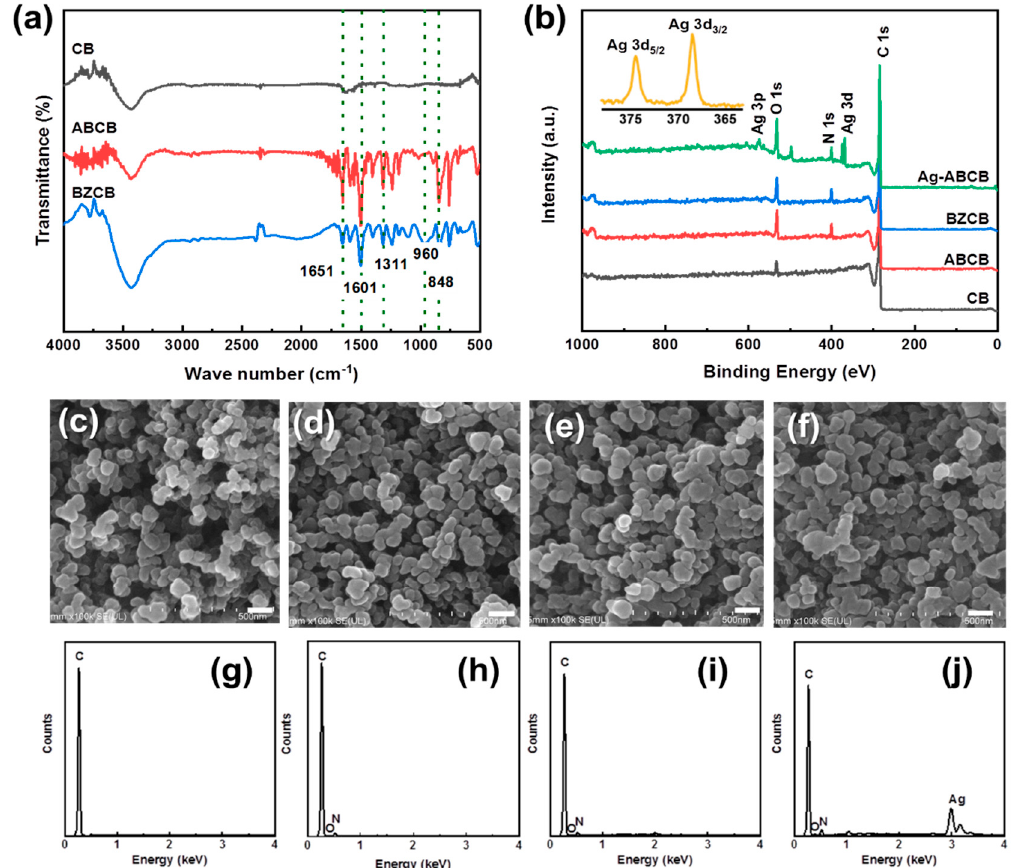
Figure 3. ( a ) FT-IR and ( b ) XPS spectra of CB, ABCB, and BZCB; SEM images of ( c ) CB, ( d ) ABCB, ( e ) BZCB, and ( f ) Ag-ABCB. Scale bar is 100 nm. EDX analysis of ( g ) CB, ( h ) ABCB, ( i ) BZCB, and ( j ) Ag-ABCB.